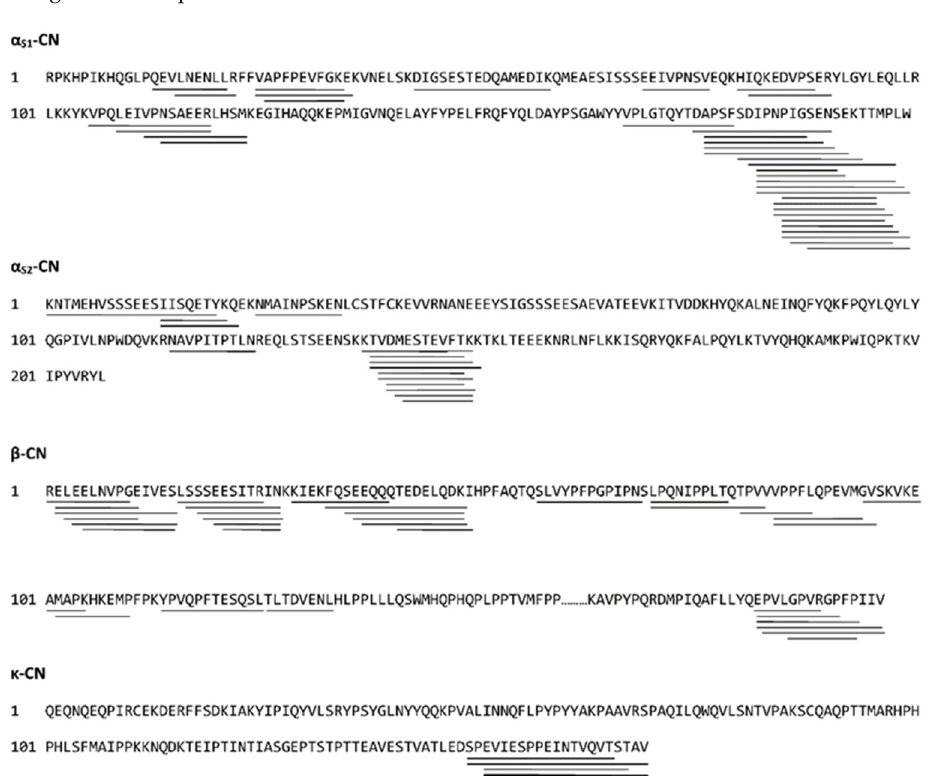
Figure 2. Sequences of the bovine caseins are shown. Lines under the sequences indicate peptides identified by liquid chromatography with tandem mass spectrometry (LC-MSMS) analysis; casein (CN).